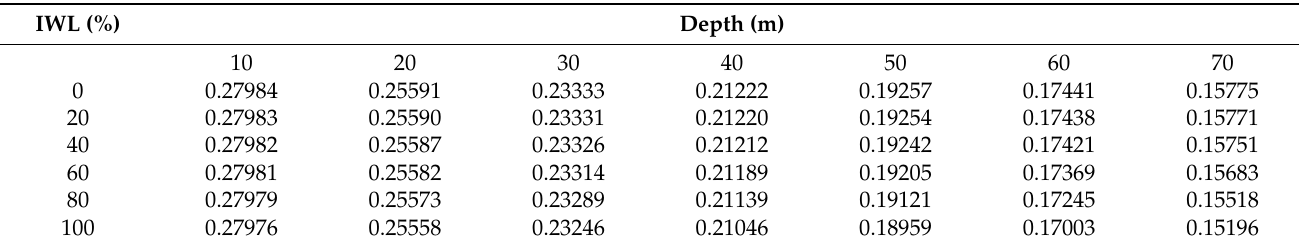
Table 7. Results of natural frequency analysis for first fore-aft mode. Table 8. Results of natural frequency analysis for first side-to-side mode.